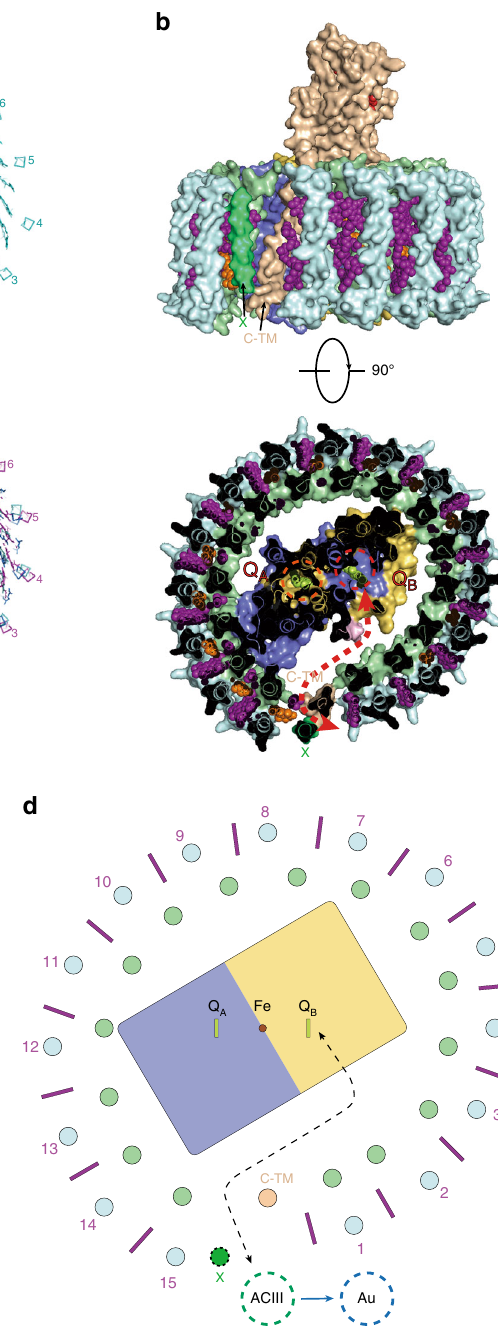
Fig. 4 Novel architecture of the RC – LH complex of R. castenholzii and its quinone shuttling channel. a Ribbon representation and comparison of the transmembrane architecture of the core complex from R. castenholzii (purple) with that of T. tepidum (blue, accession code 3WMM) and Rhodops. palustris (cyan, accession code 1PYH). The BChl pigments in LH are shown in sticks. The transmembrane helices of the Cyt c subunit, H subunit, protein W, and subunit X are labeled as C-TM, H, W, and X, respectively. b The side and bottom-up view of the proposed quinone channel of rc RC – LH complex. The BChls and keto- γ -carotene are shown as spheres. The gap between the C-TM and the 15th LH αβ is proposed to be the quinone escape channel. The quinone- binding sites are highlighted by red and orange circles, and the possible quinone shuttling path is shown as red arrows. c Schematic model of the energy and electron transfer in rc RC – LH complex. The model shows one cross-section that is perpendicular to the membrane. The B800, keto- γ -carotene, and B880 are highly conjugated and the energy from sunlight can be harvested and transferred ef fi ciently among them (red arrows). The energy from the excited B880s also can transfer to the special-pair BChls (P), and facilitate the charge separation. The electron can then transfer to Q B through BChl, BPheo, Q A , and iron atom sequentially (blue arrows). The P + receives one electron from heme of RC-attached tetra-heme Cyt c and the electron donor of heme is the blue copper protein auracyanin (Au), which is reduced by alternative complex III (ACIII). This diagram was created by Abode Illustrator. d The cross-section parallel to the membrane is shown as a schematic model for the quinone transfer. The LH ring barrier possesses one gate between C-TM and the 15th LH αβ for quinone shuttling, which is fl anked by subunit X. Fully reduced quinone (hydroquinone) diffuses out of the RC and is replaced by a new quinone. The hydroquinone can transfer electrons to ACIII and then reduce the Au. The color code of all panels is same as Fig.